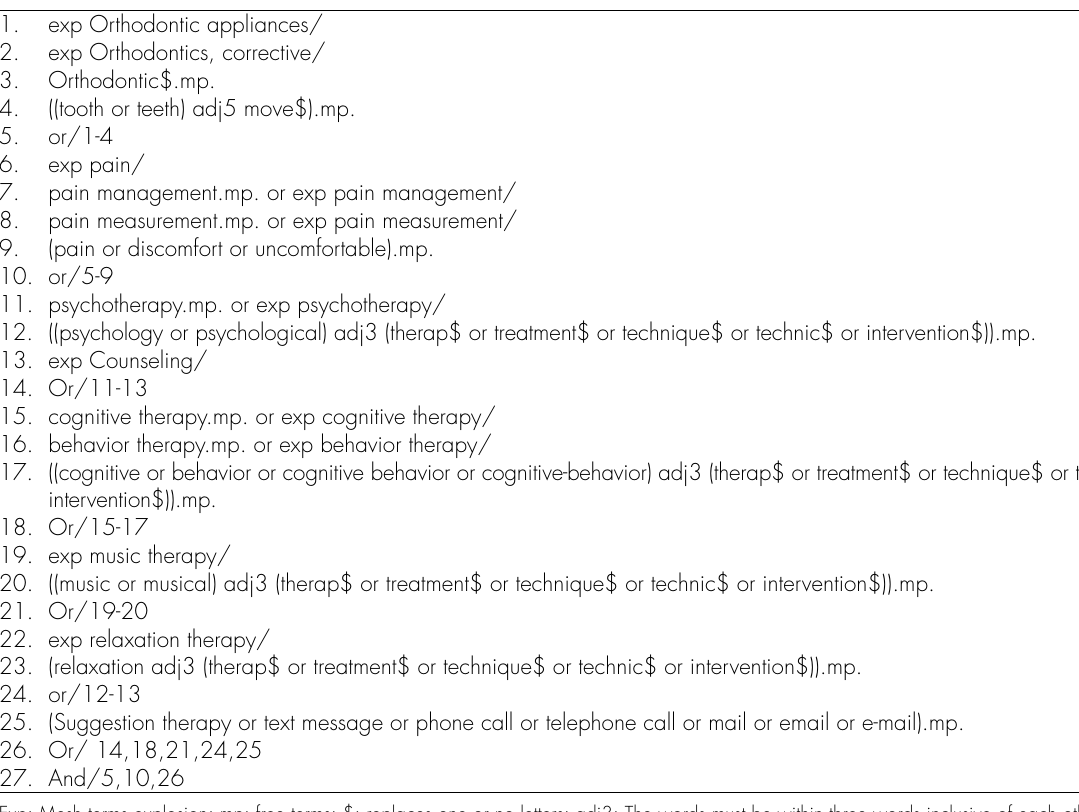
Supplementary Table I. Embase search strategy.